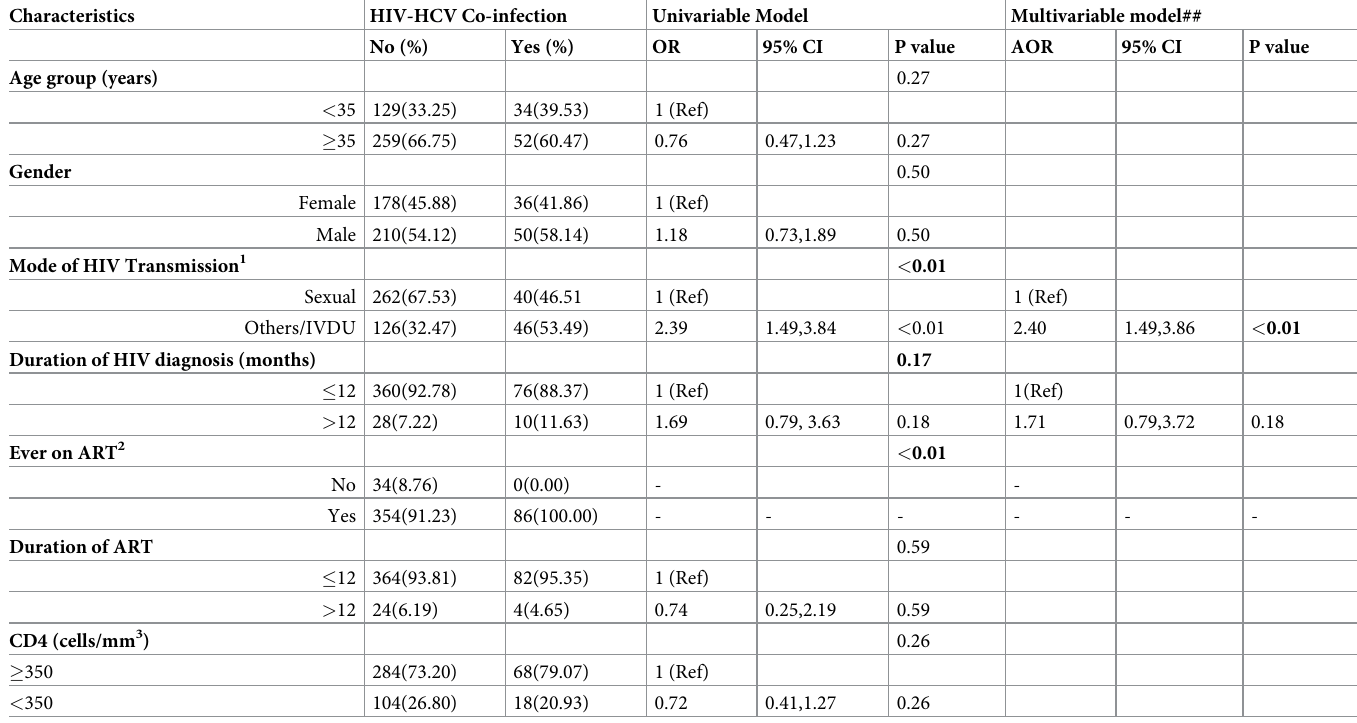
##Adjusted for mode of HIV transmission and duration of HIV diagnosis. 1 Other mode of transmission is primarily IVDU as there were no cases of HIV-HCV co-infection in PLWH acquired through vertical mode of transmission (Table 1). 2 Currently on Anti retro-viral therapy